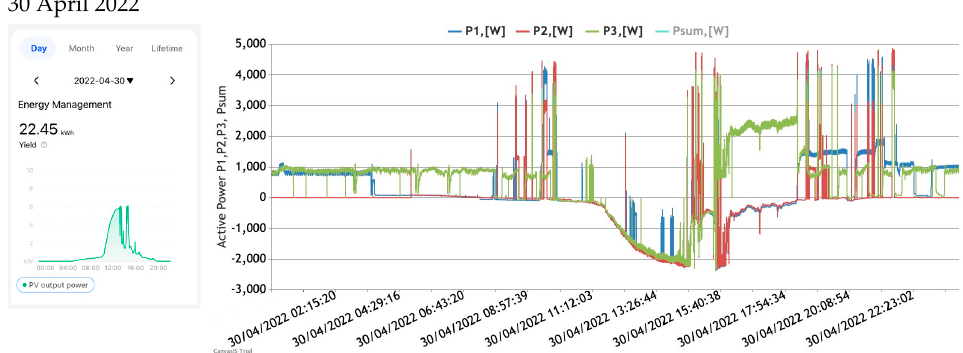
Figure 4. Generated energy profile ( left ) and registered power profile ( right ).